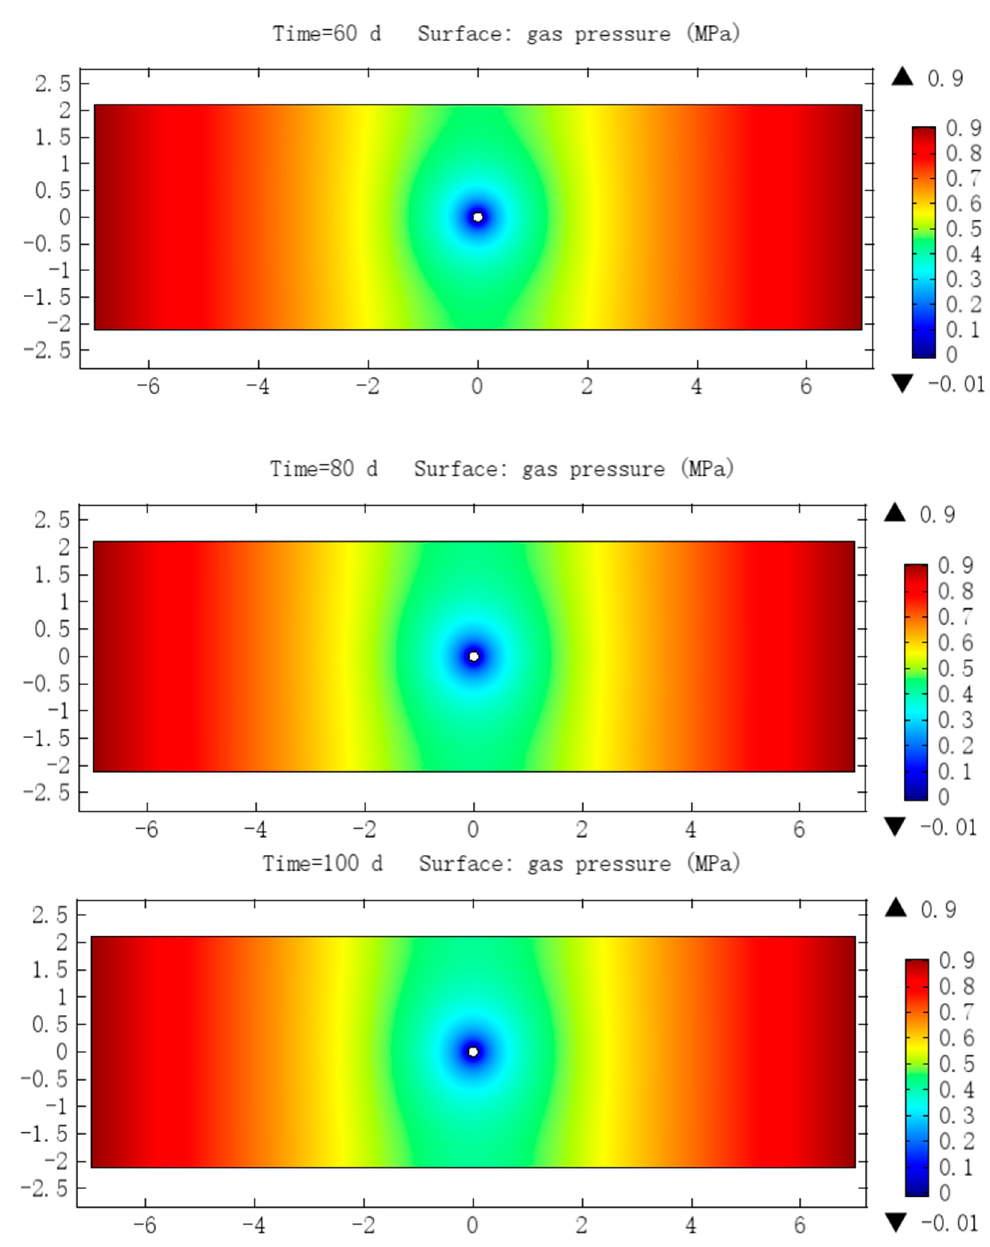
Figure 5. Gas pressure profile at different times.